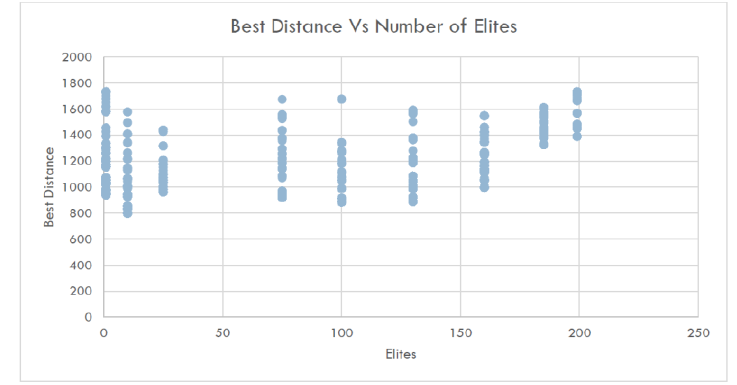
Fig. 3. Route Best Distances Compared to Size of Elite Group